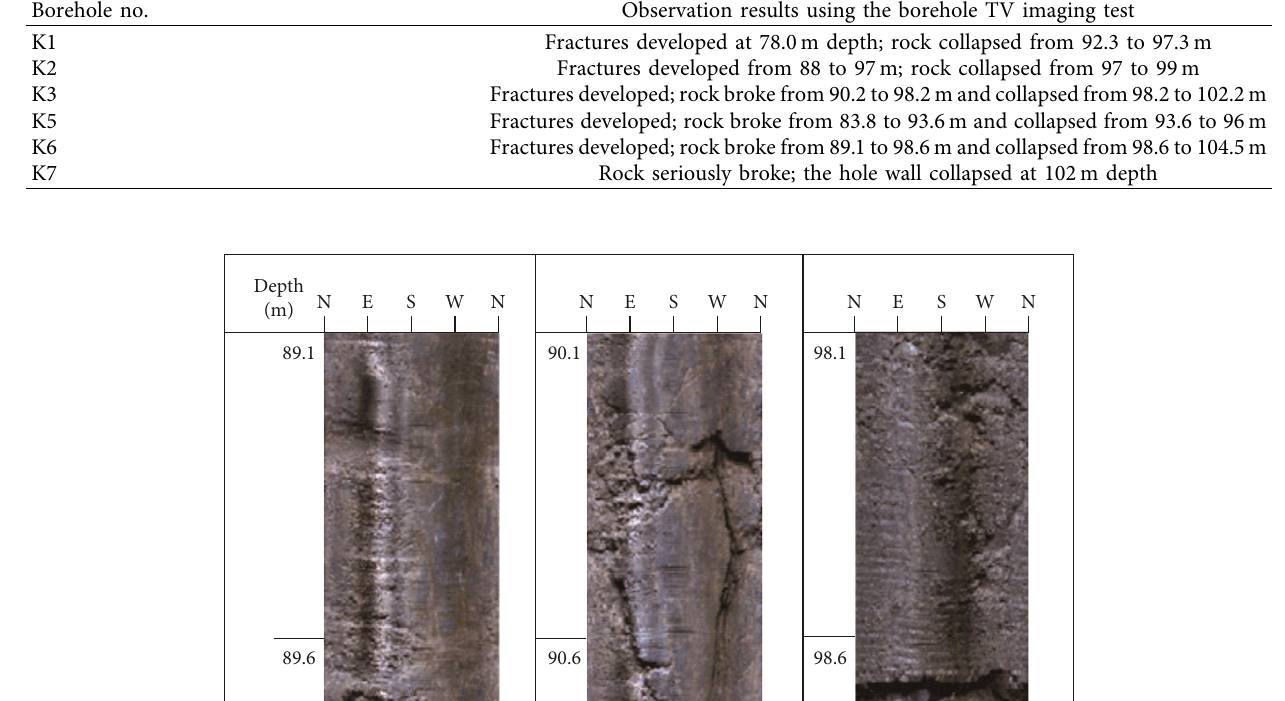
Table 2: Observation results of exploration borehole based on the TV imaging test. Borehole no.